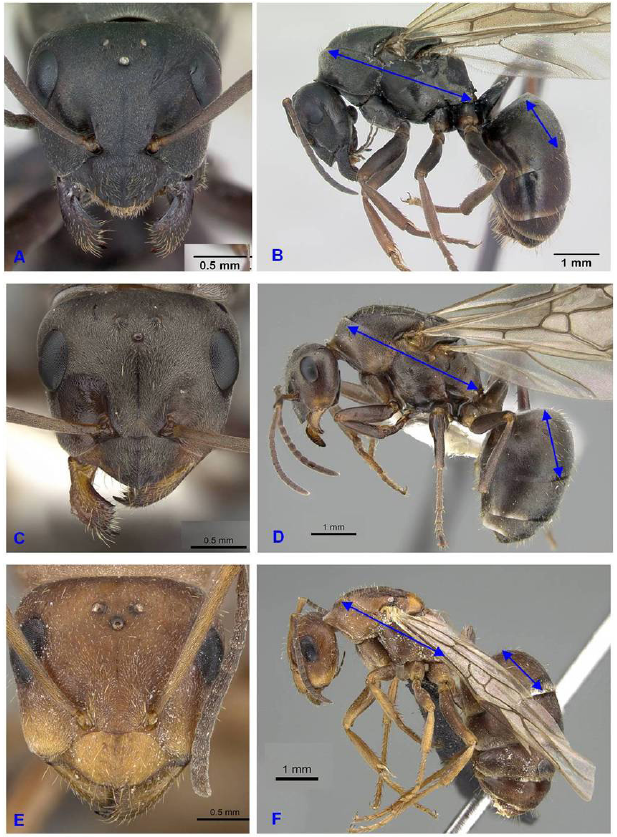
Fig 1 . Queens of Formica fusca (A, B) [CASENT0173171],